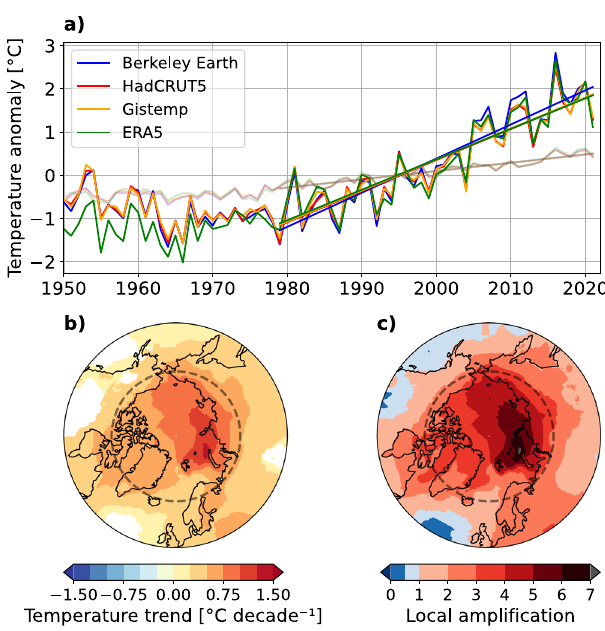
Fig. 1 Annual mean temperature evolution in the Arctic. a Annual mean temperature anomalies in the Arctic (66.5 ∘ – 90 ∘ N) (dark colours) and globally (light colours) during 1950 – 2021 derived from the various observational datasets. Temperature anomalies have been calculated relative to the standard 30-year period of 1981 – 2010. Shown are also the linear temperature trends for 1979 – 2021. b Annual mean temperature trends for the period 1979 – 2021, derived from the average of the observational datasets. Areas without a statistically signi fi cant change are masked out. c Local ampli fi cation ratio calculated for the period 1979 – 2021, derived from the average of the observational datasets. The dashed line in ( b ) and ( c ) depicts the Arctic Circle (66.5 ∘ N